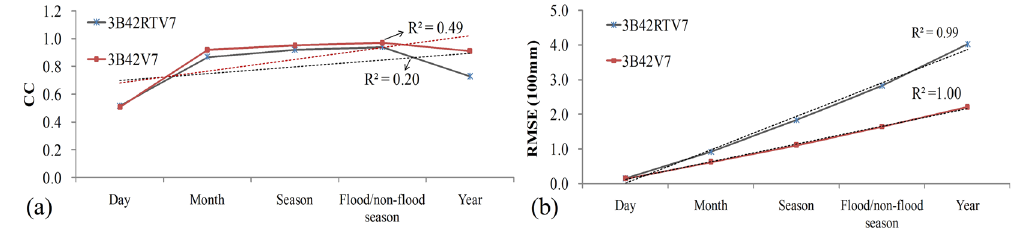
Figure 4. Temporal scale effect of TMPA products.